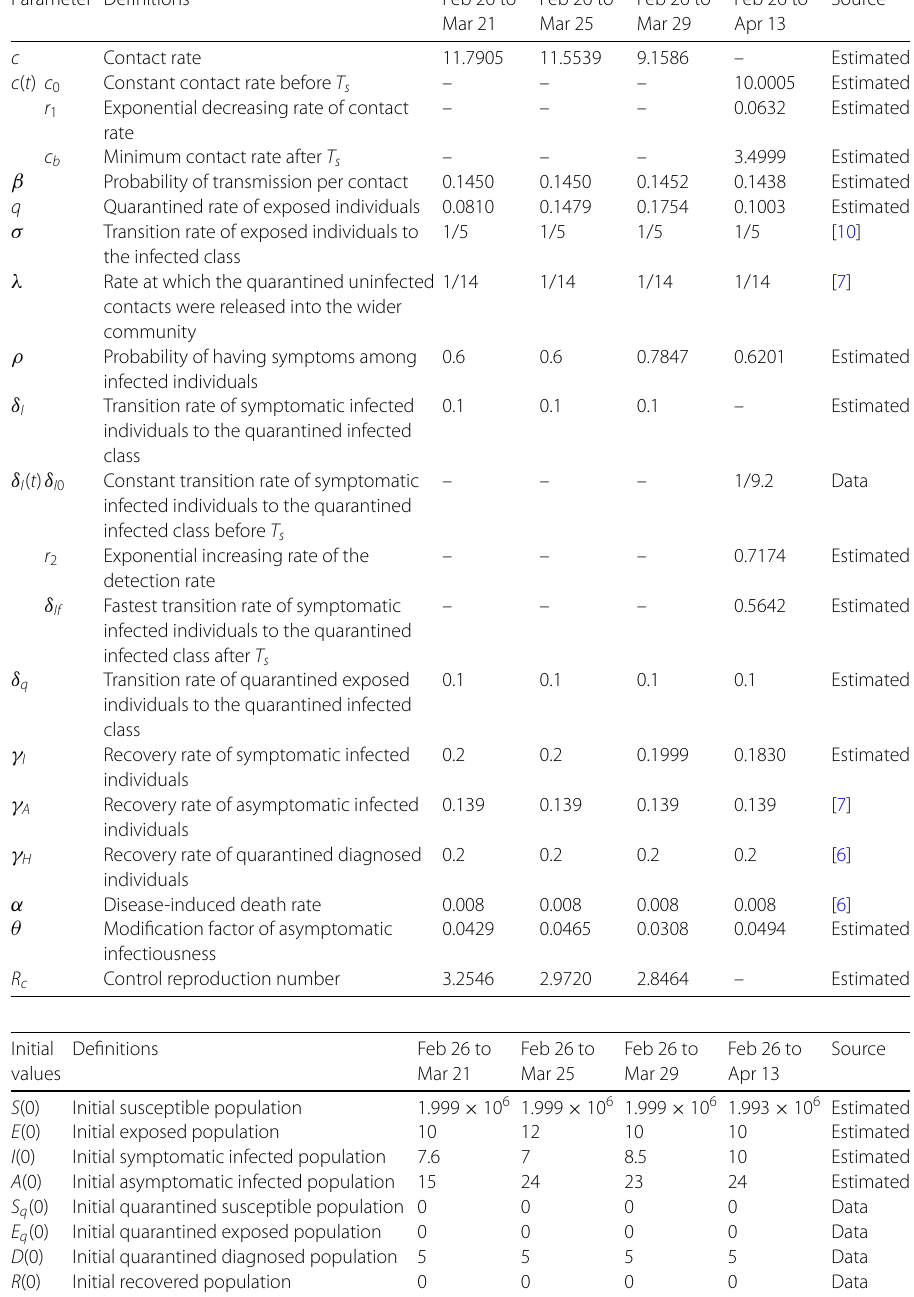
Table 1 Parameter estimates for COVID-19 in Ontario, Canada Parameter